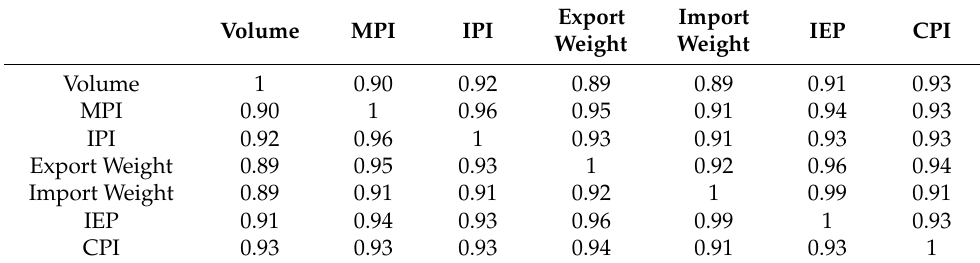
Table 2. Correlation between container volume and external